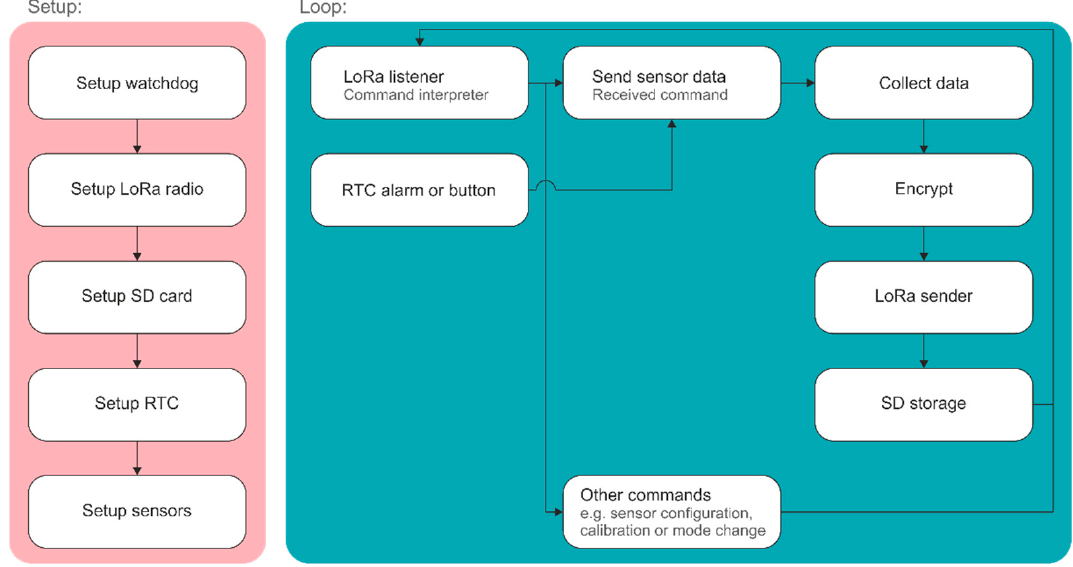
Figure 6. The architecture of the code in the node. Additional functionalities can be implemented by defining additional commands that trigger alternative workflows.